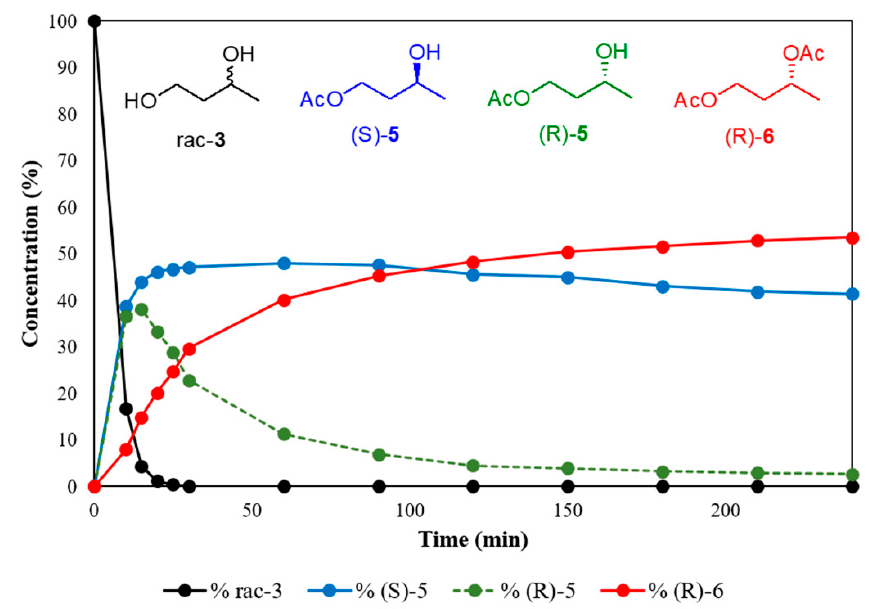
Figure 1. Time course of the CAL-B catalyzed kinetic resolution of racemic diol 3 .